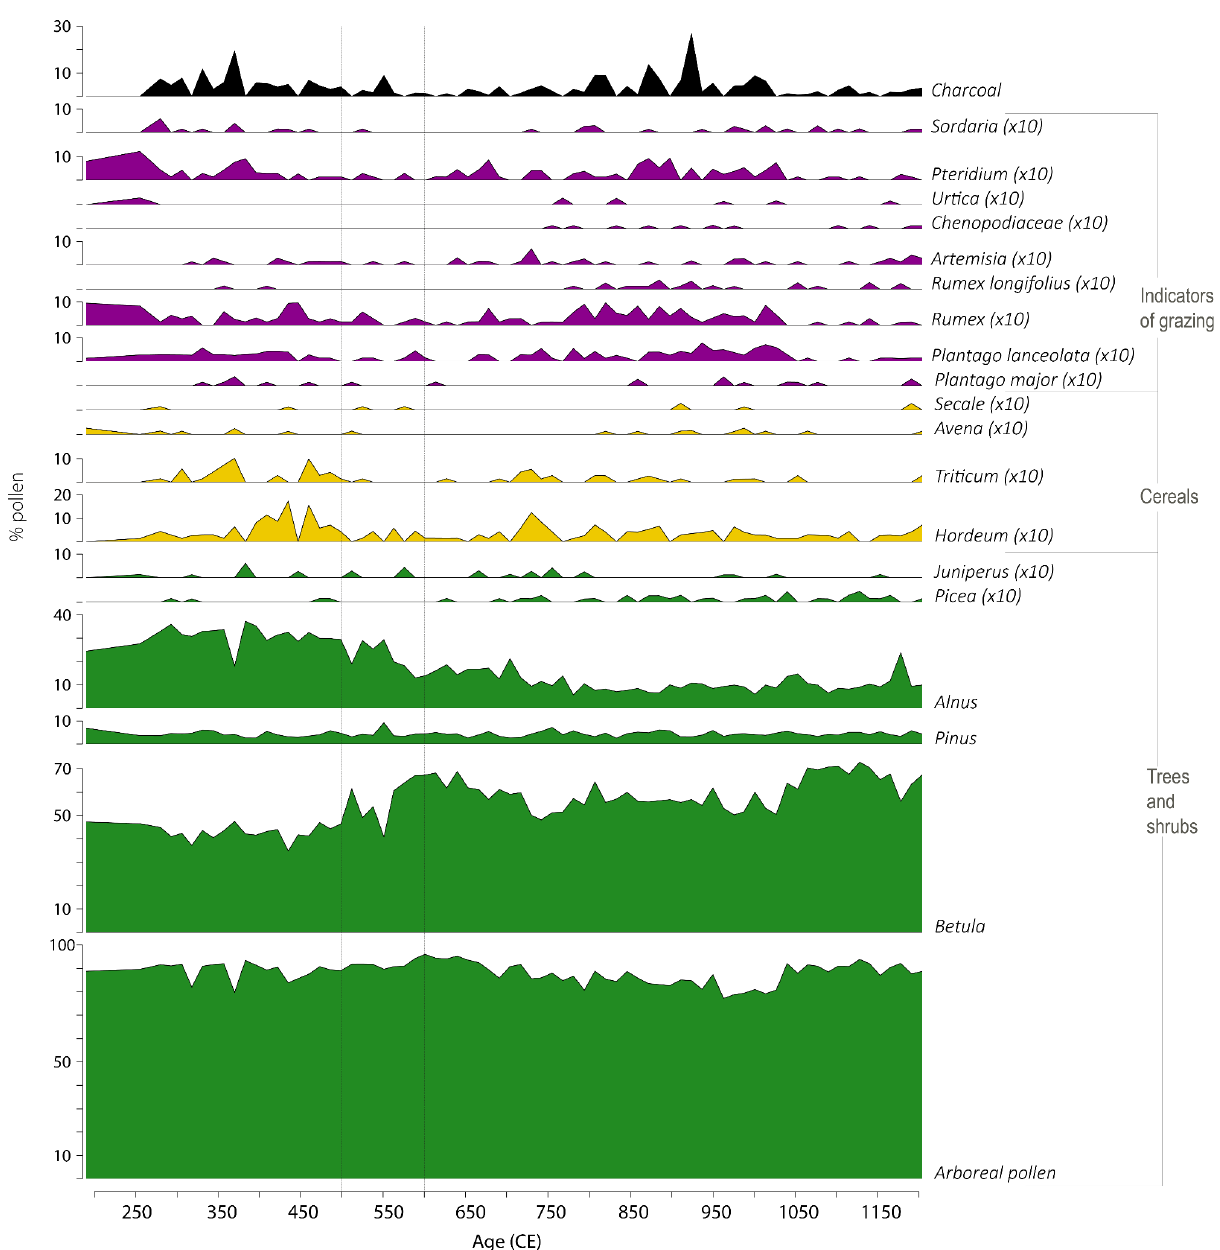
Figure A10. Percentage pollen diagram for Åsheimmyr (Forsand area), showing a selection of trees, cereals, and other anthropogenic indicators according to calibrated age (CE) from 250BCE to 1150CE. Pollen types that were multiplied by 10 are indicated with × 10 in the title for each pollen type. Percentages of pollen, spores and non-pollen palynomorphs outside the pollen sum ( X ) are based on (cid:54)P + X .